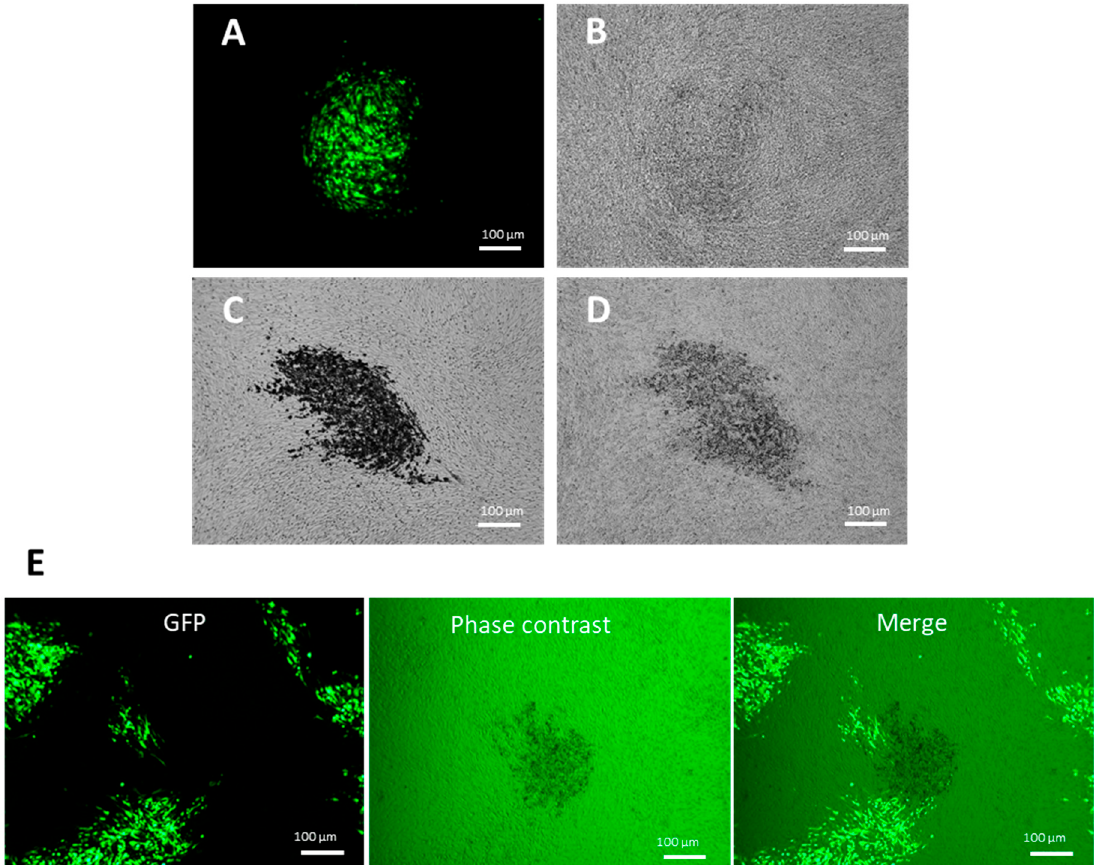
Figure 3. Selection of recombinant HVT–H7HA using chicken erythrocyte binding. Chick embryo fibroblast (CEF) cells were infected with HVT–GFP, HVT–H7HA, or unpurified HVT–H7HA and then subjected to chicken erythrocyte binding. CEF cells infected with HVT–GFP under UV excitation ( A )